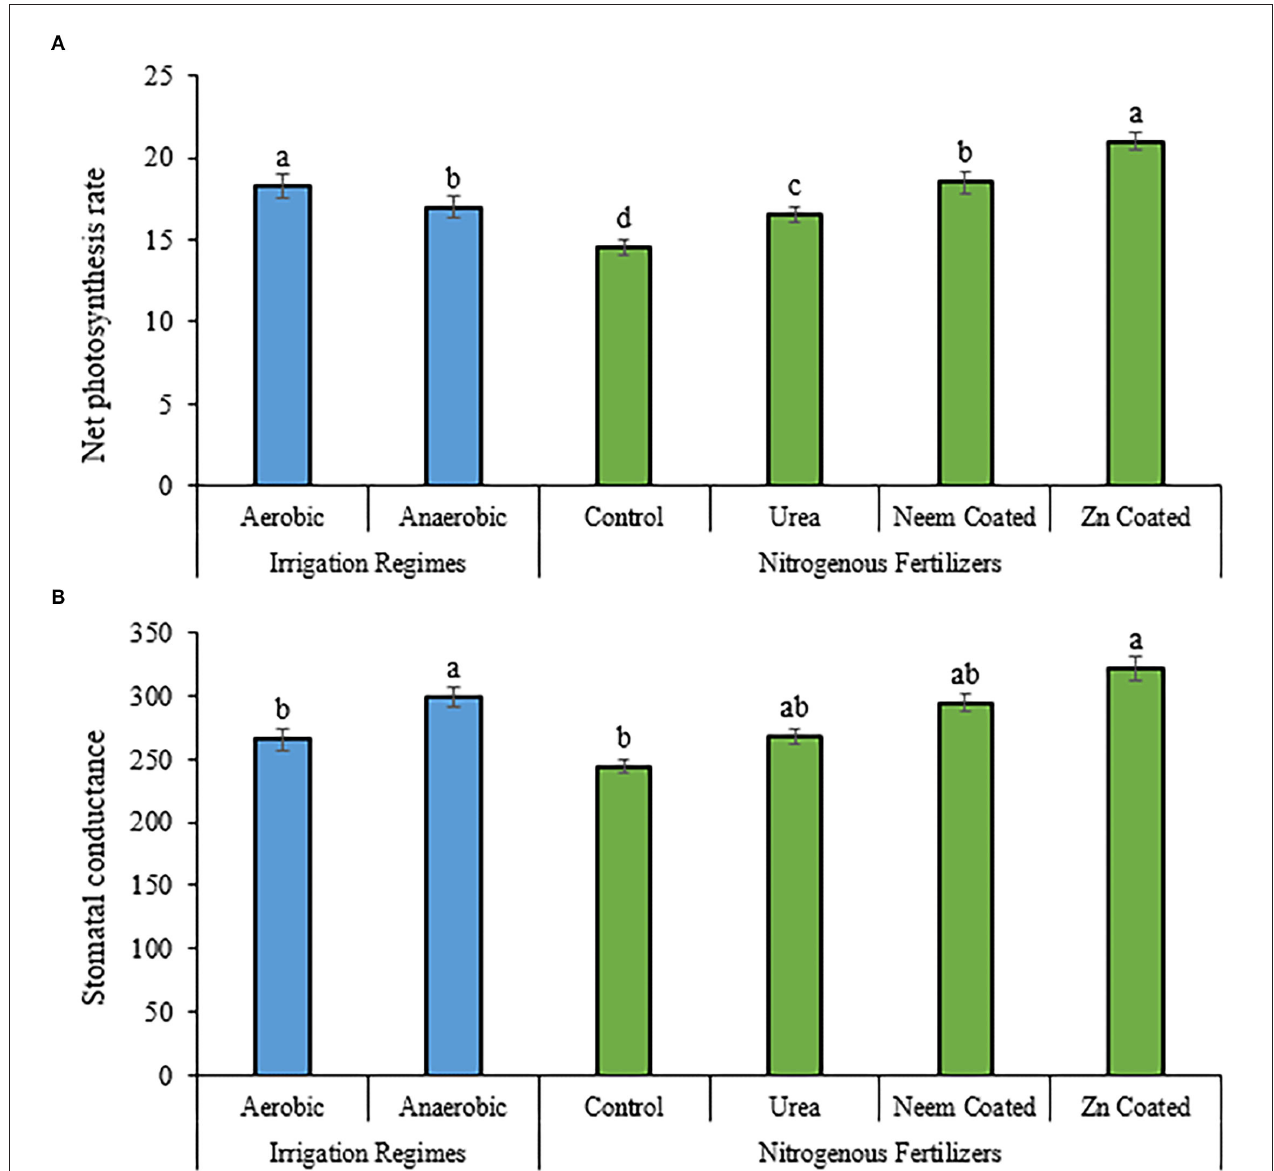
FIGURE 1 | Influence of slow release nitrogenous fertilizers on mean values of net photosynthesis rate (A) and stomatal conductance (B) of rice cultivated under aerobic and anaerobic